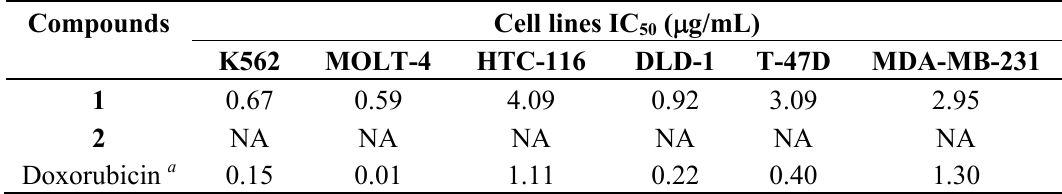
Table 2. Cytotoxic data of norcembranoidal diterpenes 1 and 2 .